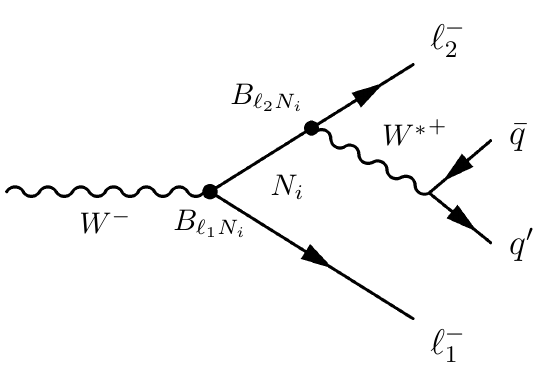
‘ − ( q 0 ¯ q ) + via an intermediate N i . There is no arrow on the N i 1 2